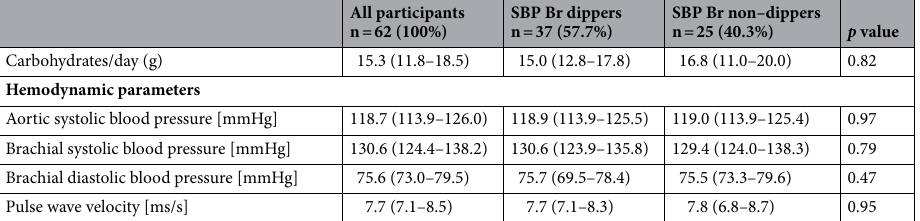
Table 2. Comparison of groups with and without the brachial non-dipping pattern according to the Arteriograph 24 results. Data presented as median (IQR) / n(%). Bold values denote statistical significance at the p < 0.05 level. ACR albumin to creatinine ratio, ALT alanine transaminase, AST aspartate transaminase, BMI body mass index, Br brachial, HbA1c glycated hemoglobin, HDL-C high-density lipoprotein, LDL-C low- density lipoprotein, SBP systolic blood pressure, WHR waist-to-hip ratio.